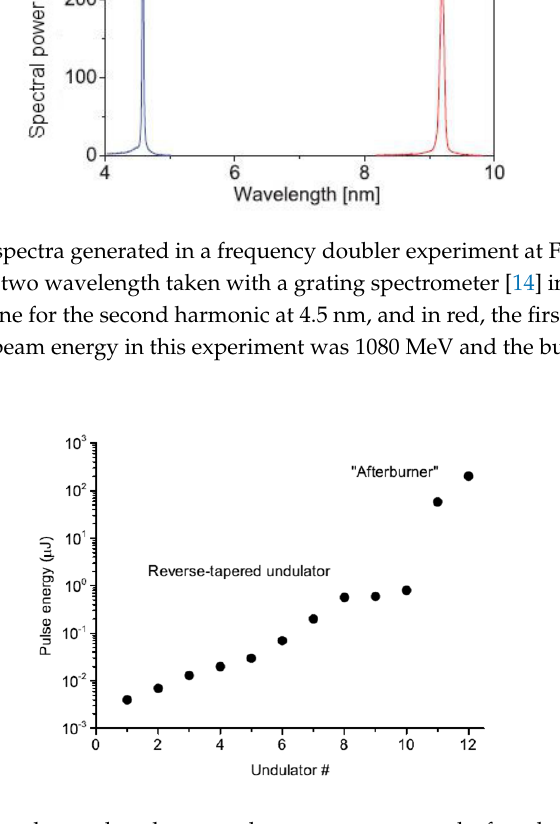
Figure 12. The figure shows the photon pulse energy measured after the respective undulator in FLASH2. Undulators 1 to 10 were set to reverse tapering while the final two act as an afterburner, leading to an increase in pulse energy by a factor of